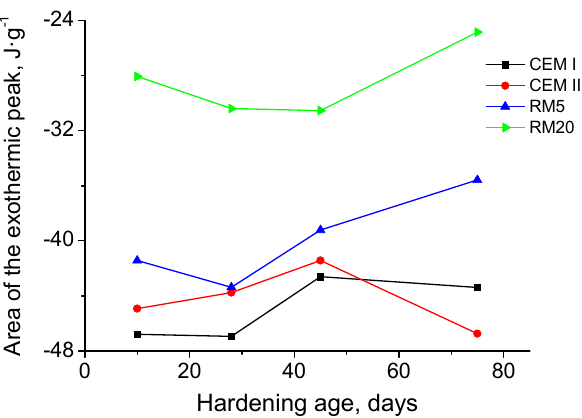
Figure 7. Evolution with hardening time of the heat liberated in the peak corresponding to the decomposition of portlandite.